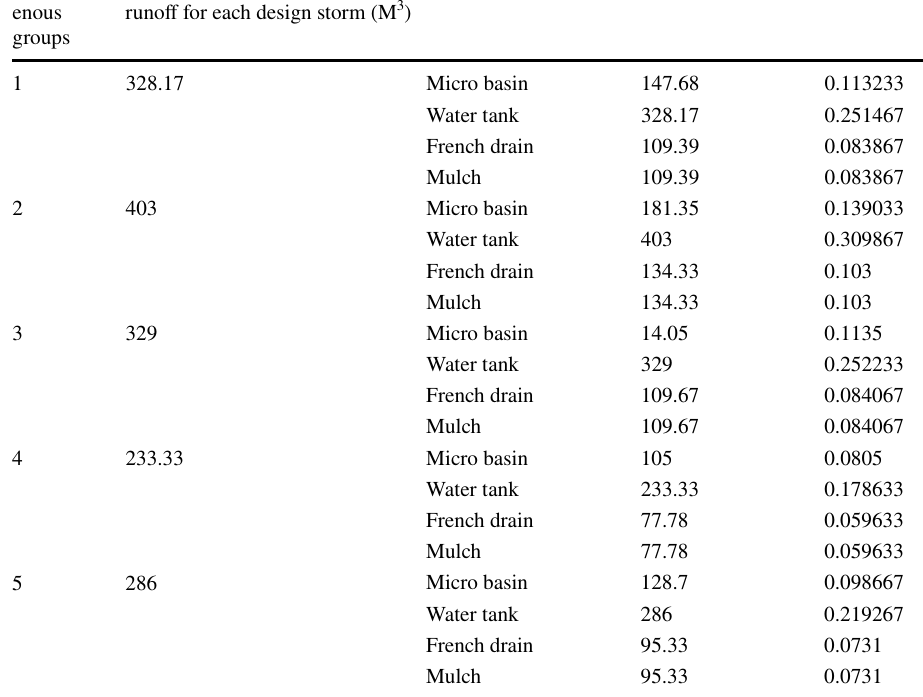
Table 5 The benefits of the proposed RWHSs